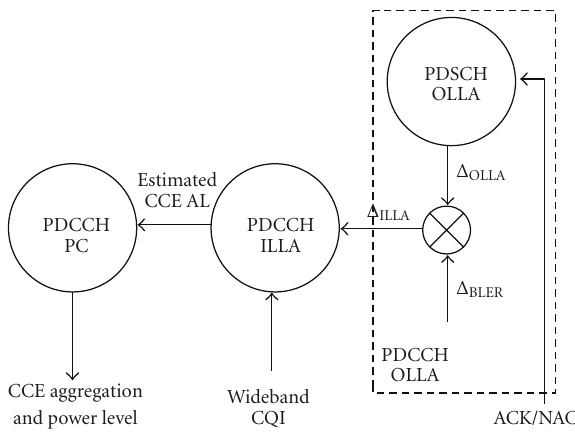
Figure 3: PDCCH resource allocation: power control and link